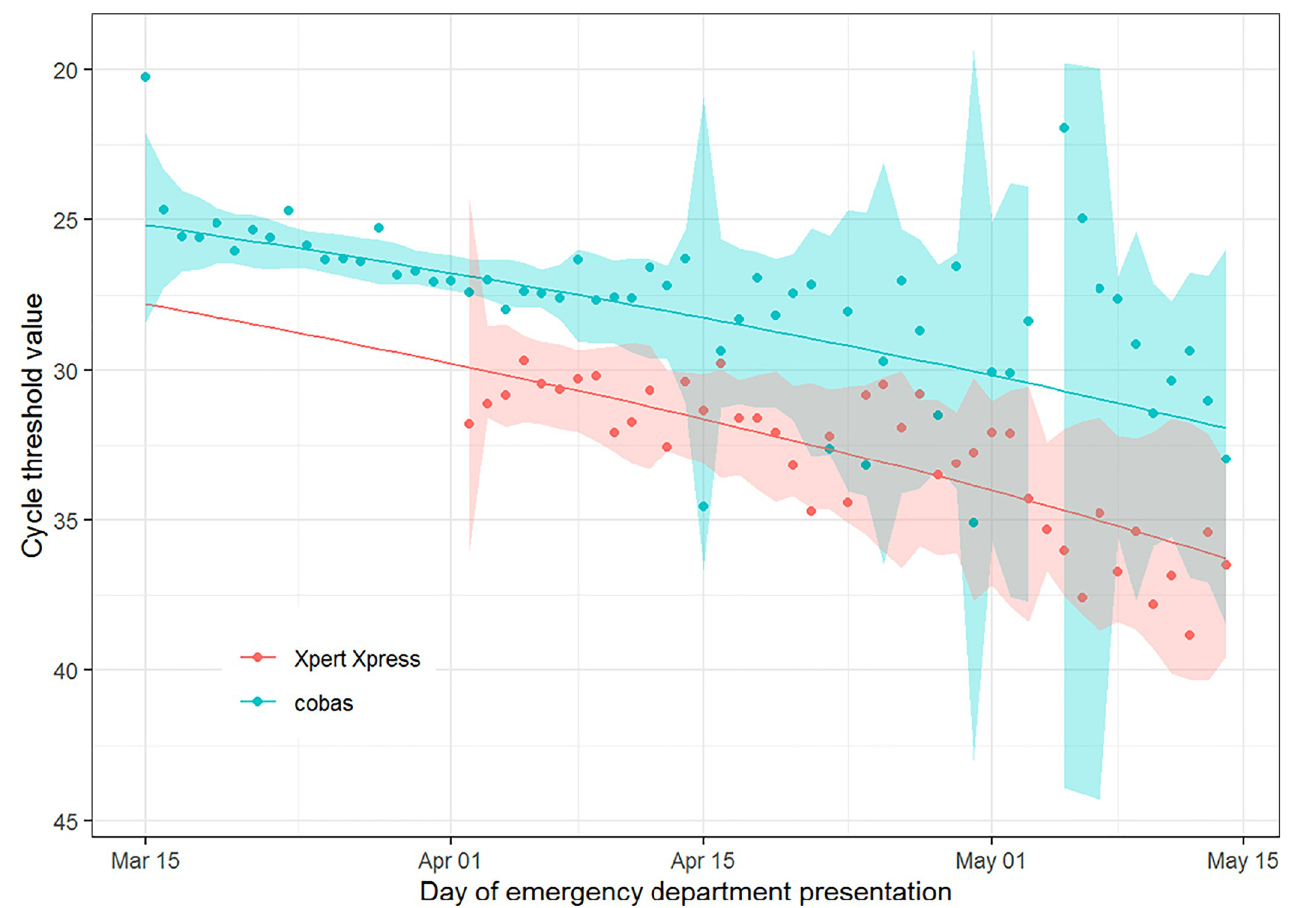
Fig 1. Cycle threshold values from SARS-CoV-2-specific RT-PCR tests among patients presenting to the emergency department with COVID-19 over time, separated by type of SARS-CoV-2 assay. Shaded areas represent 95% prediction intervals and lines are best-fit curves from a Gamma regression model. The ratio of expected C values for each assay type on consecutive days was 1.004 (95% CI: 1.0036–1.0046). T